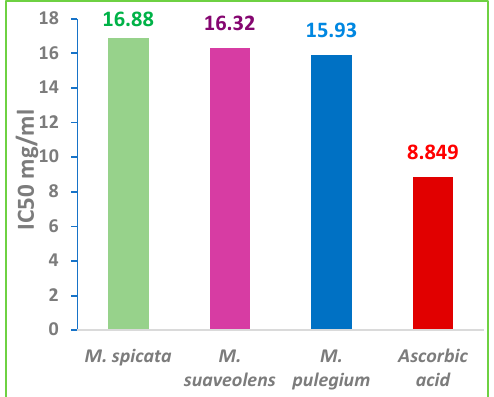
Figure 5. IC 50 values of the mint EOs and ascorbic acid.